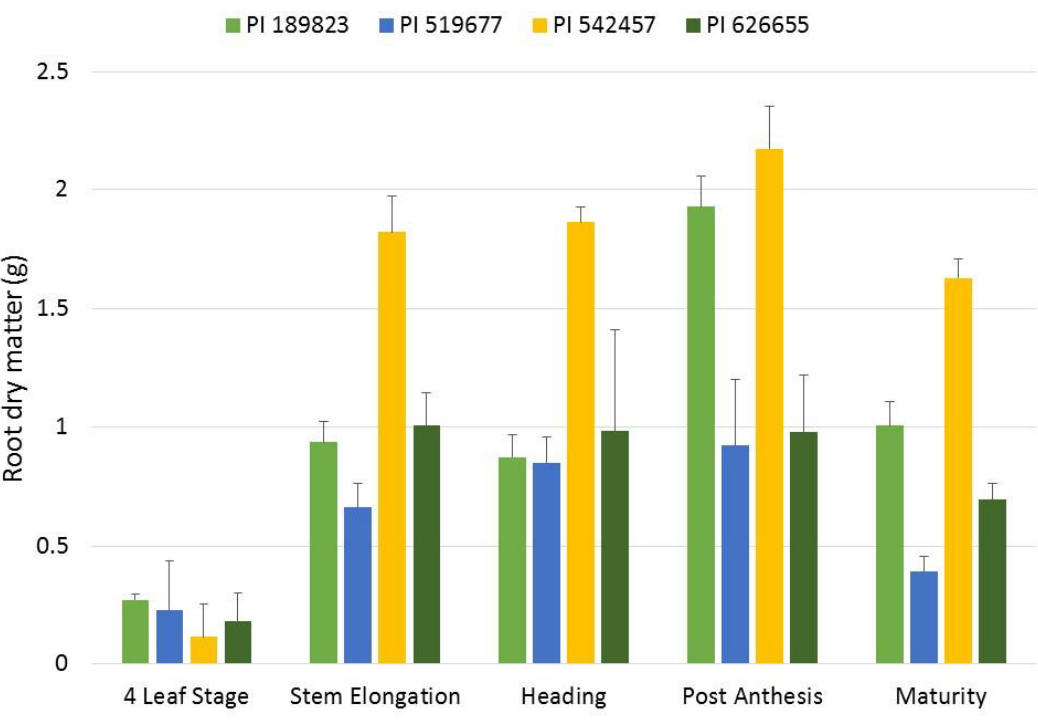
Figure 6. Increases in root dry matter in the four lines across the sampling points. Mean root dry matter for each of the four lines at the five growth stages sampled in the temporal assay are presented. Error bars represent the standard errors of the means. The di ff erent colors represent the di ff erent lines in the study shown in the legend above the figure.